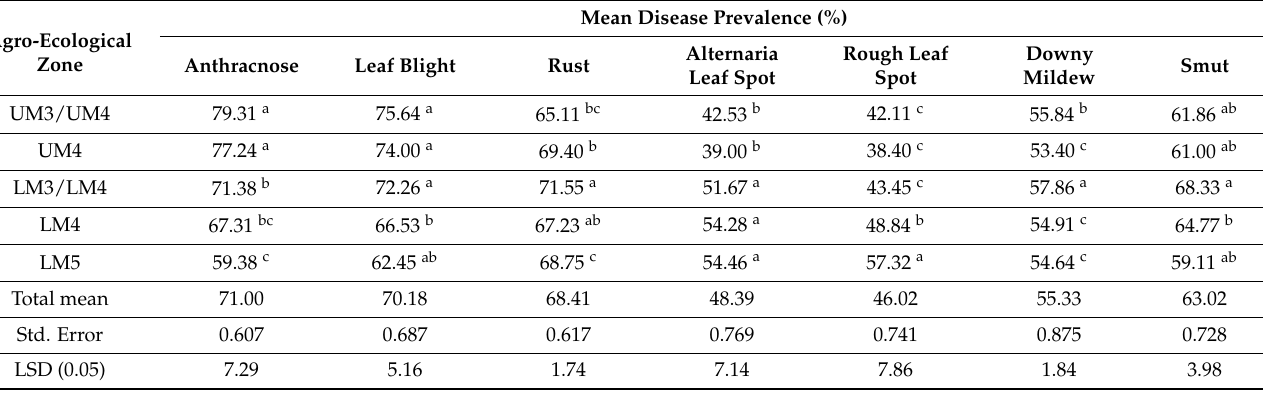
Table 2. Foliar and panicle fungal disease prevalence observed in agro-ecological zones of lower eastern Kenya.